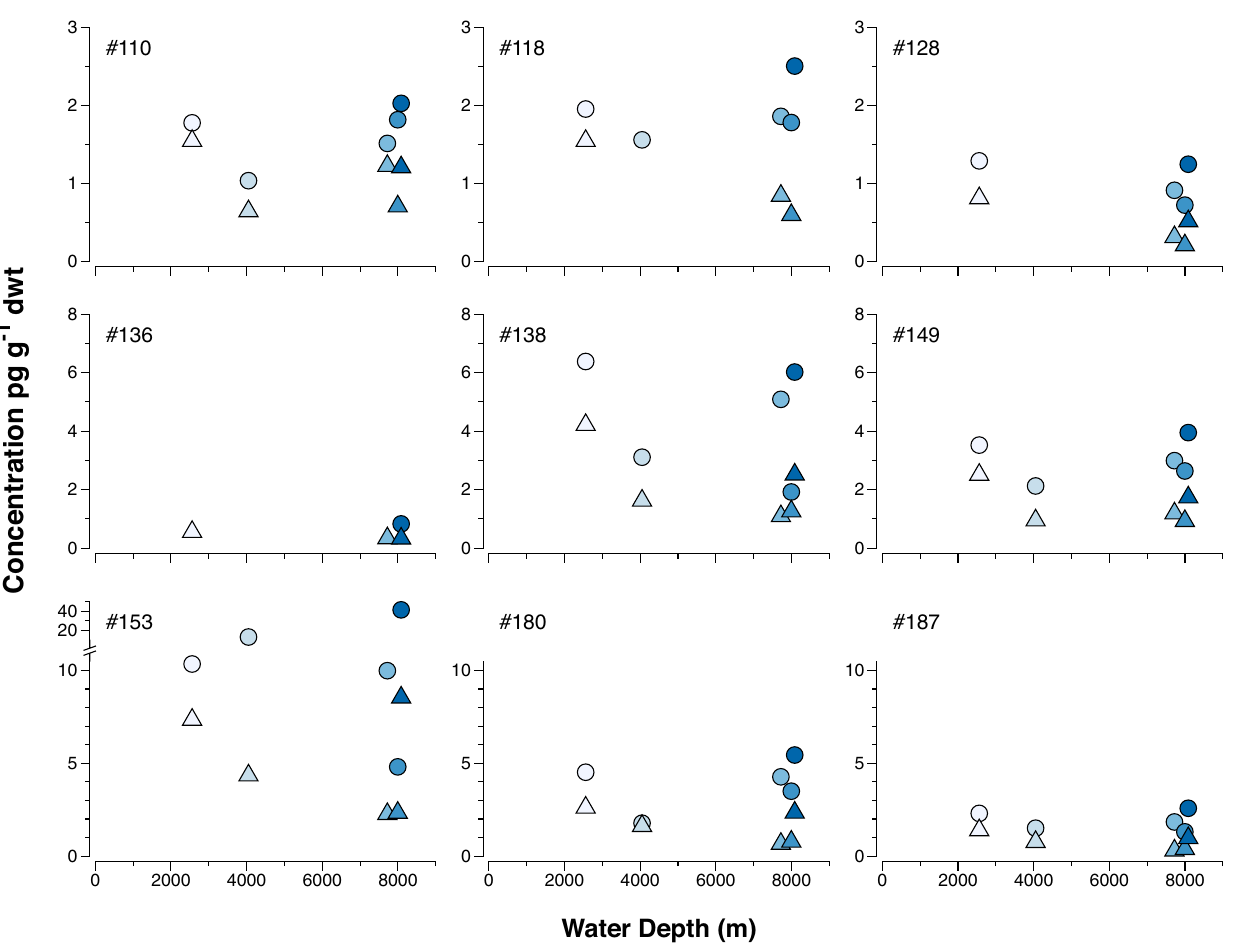
Fig. 3 | Concentrations of nine polychlorinated biphenyl (PCB) congeners in pg g − 1 dwt in Atacama sediment (upper 40mm) versus water depth. Sediment concentrations in layer 0 – 20mm are depicted by circles and in layer 20 – 40mm by triangles. Colors from bright to dark indicate water depth from shallow to